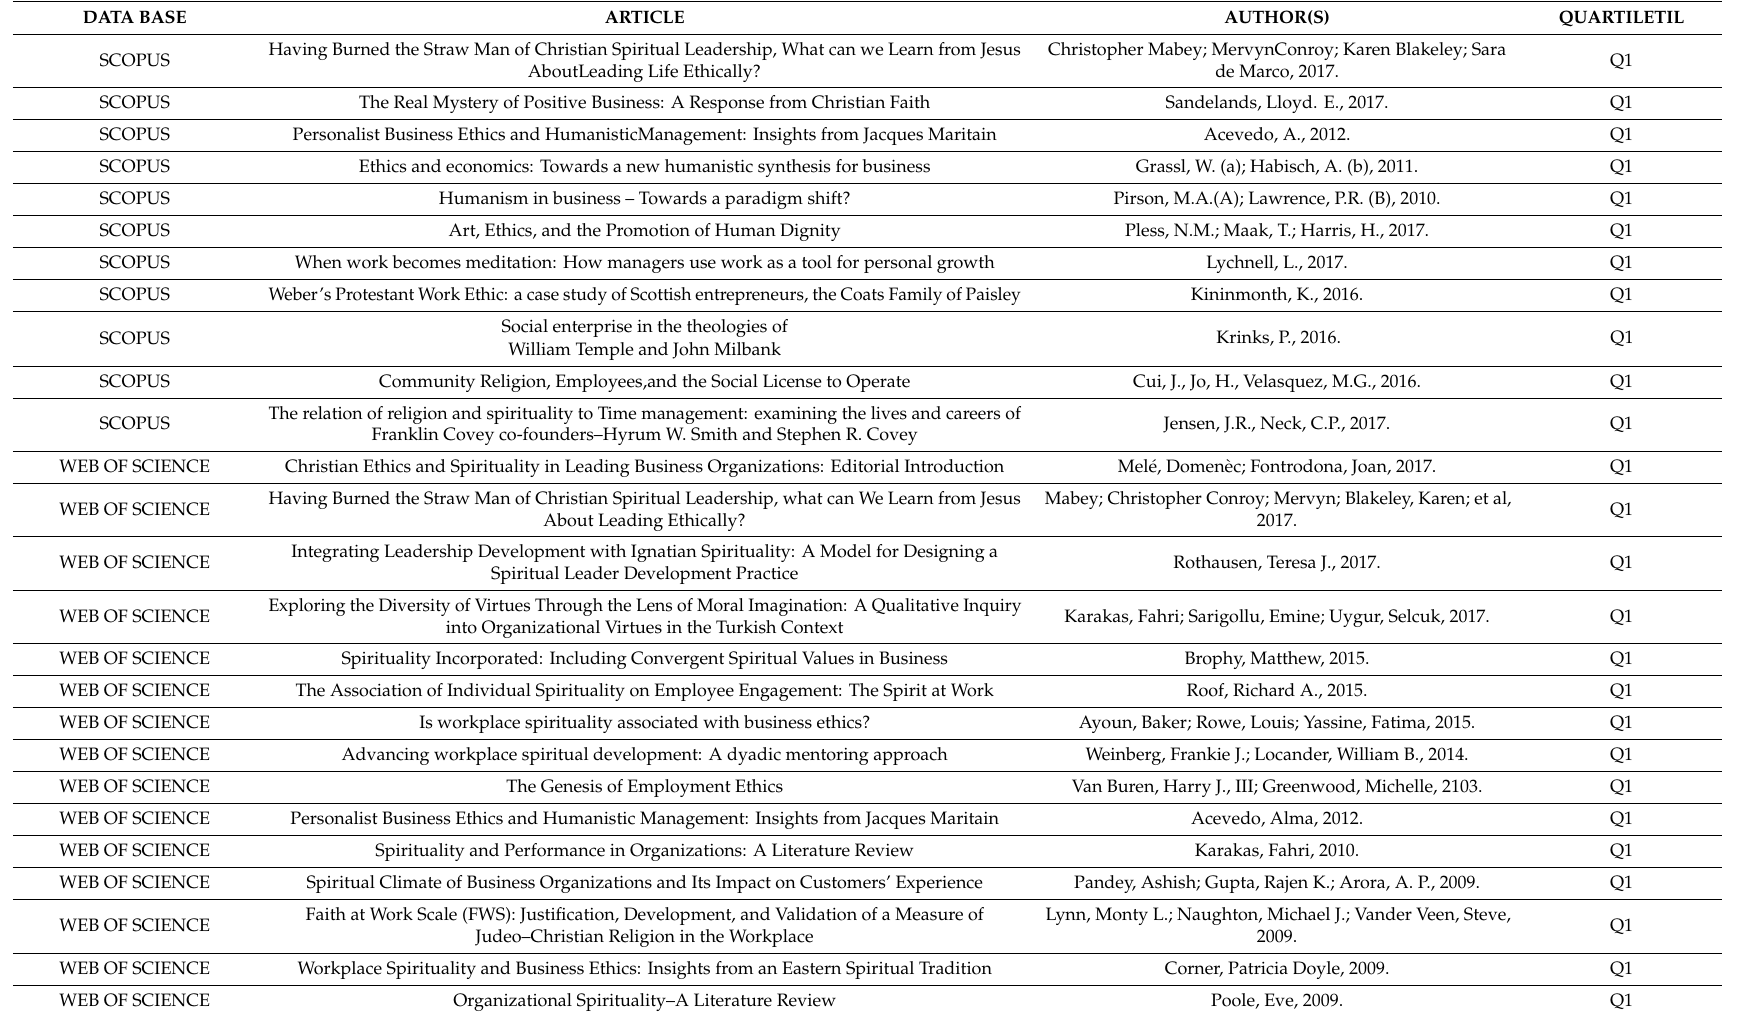
Table 1. Classification of the articles found in the